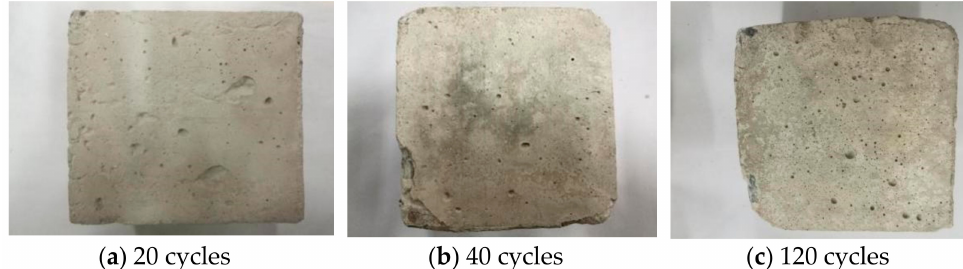
Figure 13. Macro morphology of concrete in the Na 2 SO 4